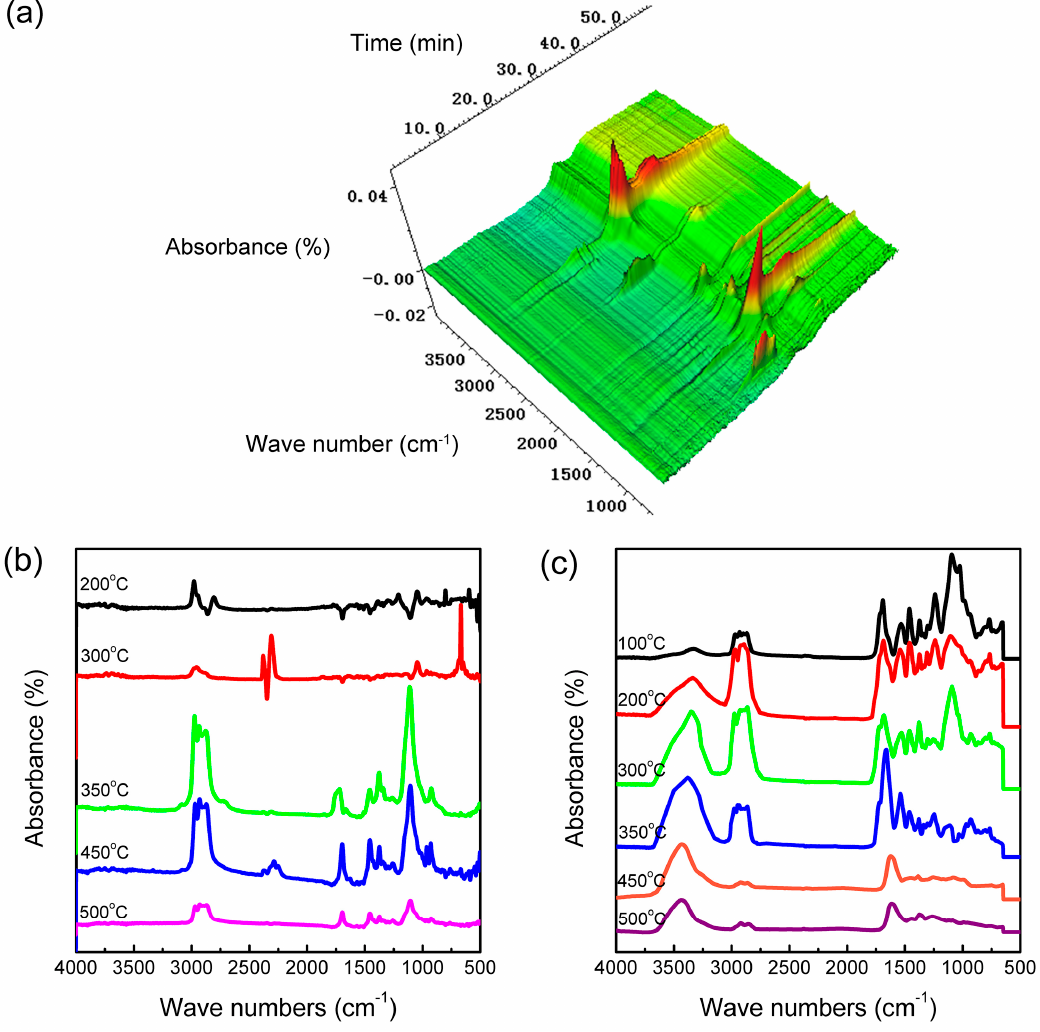
Figure 7. TGA-FTIR and FTIR of carbon residue of NOWPU-1.0 film: ( a ) three-dimensional spectrum; ( b ) TGA-FTIR at various temperature; and, ( c ) FTIR of carbon residue at various temperature.